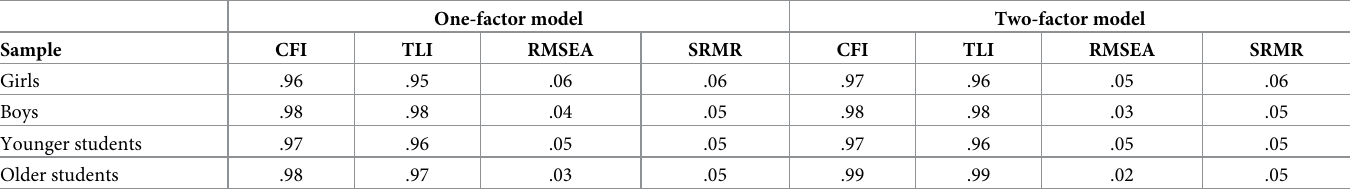
Table 2. Goodness of fit indices for the one- and two-factor models of SEMA split by gender (girls and boys) and age, with younger (3 rd and 4 th graders), and older students (5 th and 6 th